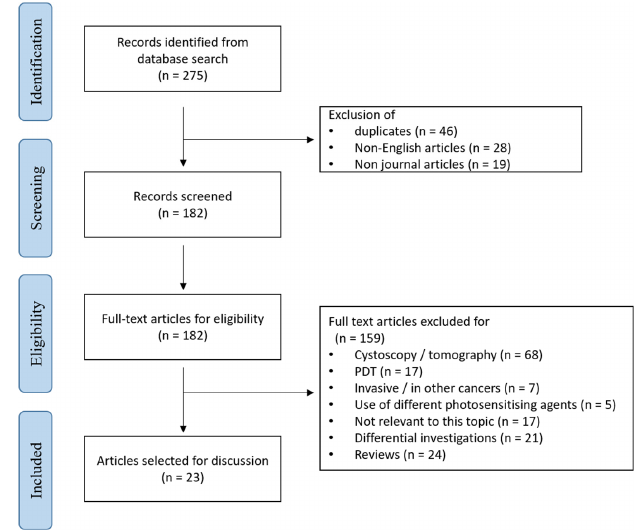
Figure 5. Flow diagram of evidence acquisition. Table 3. Studies of prodrug application in cell lines or in vivo .